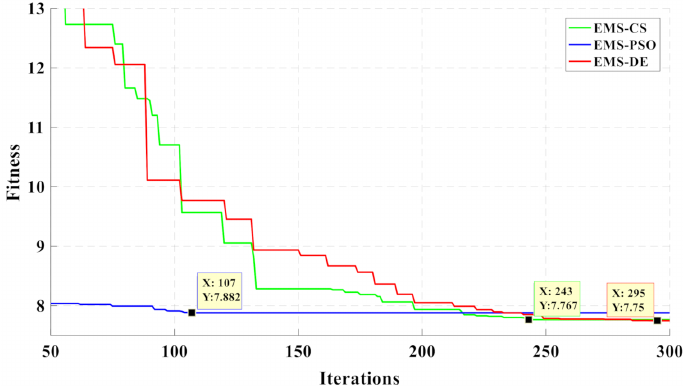
Figure 8. Convergence chart.